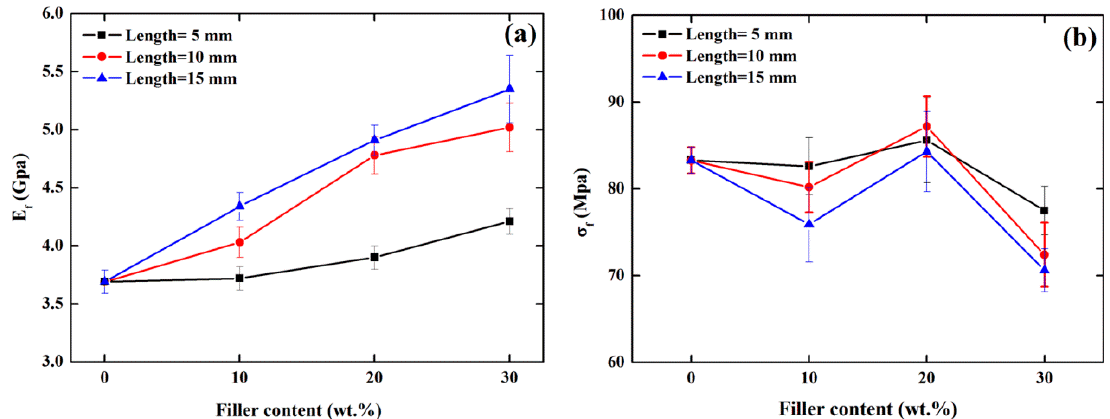
Figure 14. Filler length and content effect on the flexural modulus ( a ) and strength ( b ) of bamboo fiber composites. Table 3. The flexural properties of alkali-treated bamboo fiber reinforced epoxy composites.